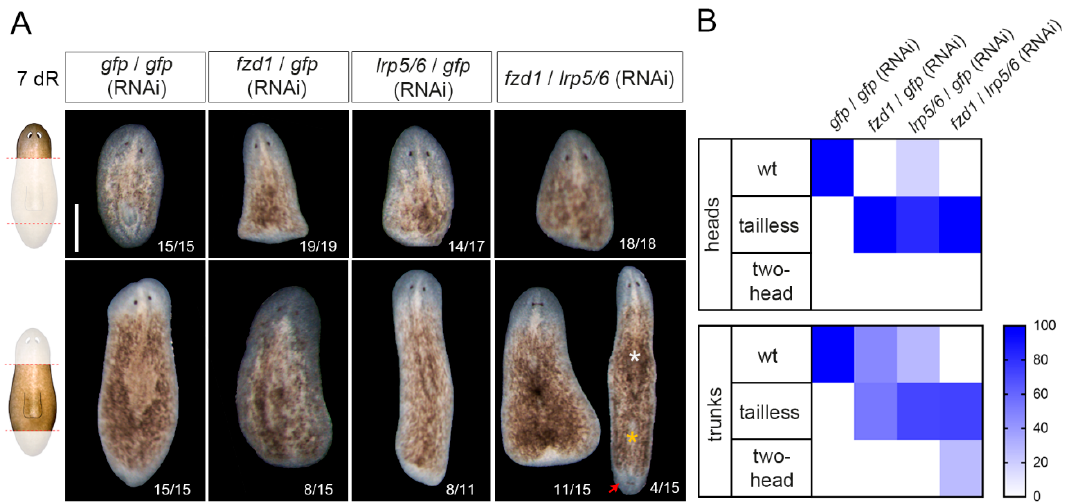
Figure 3. The simultaneous inhibition of fzd1 and lrp5/6 leads to changes in posterior polarity. ( A ) In vivo images of fzd1, lrp5/6, and the double RNAi showed that compared to controls, heads presented tailless, rounded blastemas. Trunks of fzd 1 or lrp5/6 (RNAi) also presented the tailless phenotype, and the double RNAi presented tailless and two-head planarians (red arrow). Asterisks indicate the old (white) and new (orange) pharynges. Schematic illustrations are added showing which parts were analyzed. Scale bar: 500 µm. ( B ) Heat maps show the percentage of phenotypes observed in each experimental condition.